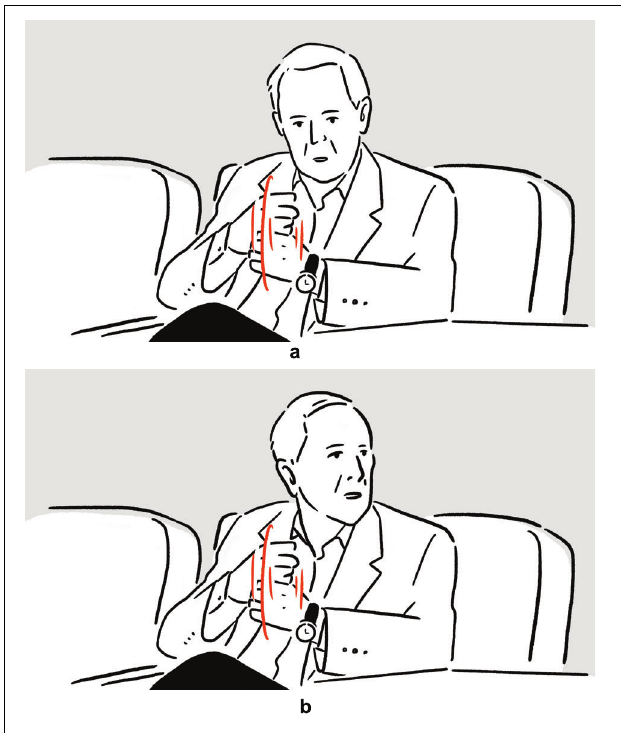
FIGURE 6 | Depictions in (9).